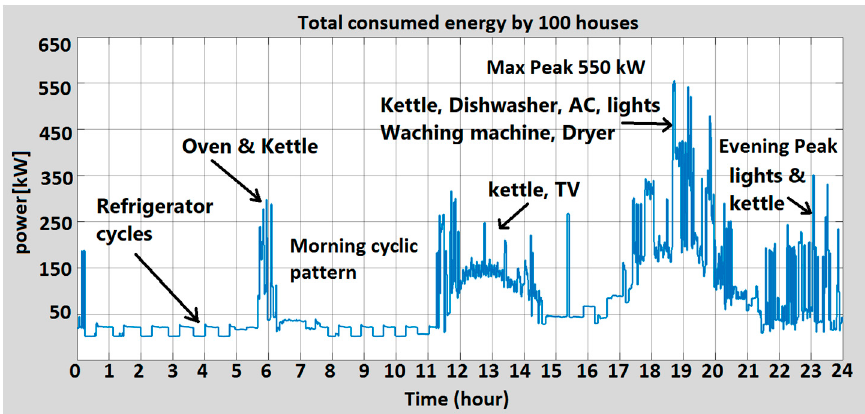
Figure 18. Total energy demand of 100 houses on a typical day.